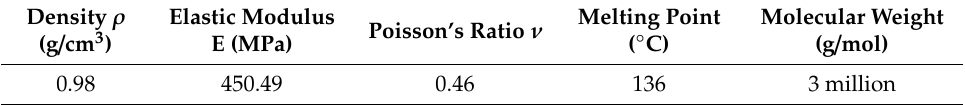
Figure 1. The manufacturing process of UHMWPE specimens. Table 1. Properties parameters of UHMWPE.